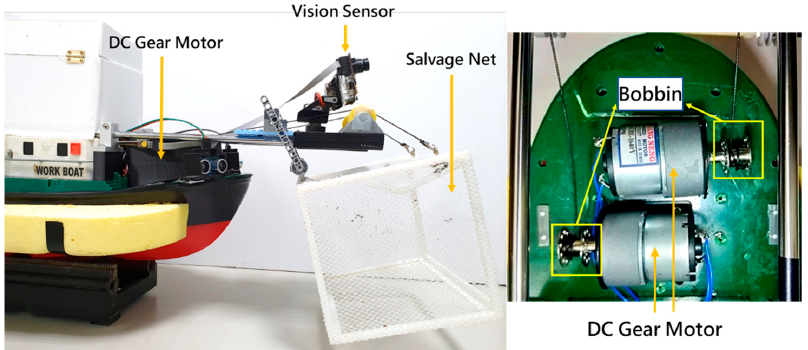
Figure 11. The position of the water surface cleaning system mounted on the MF-USV.